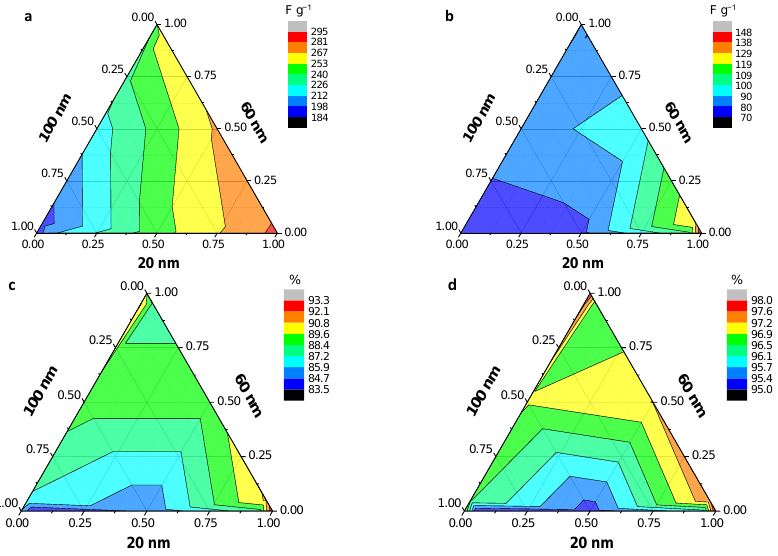
Figure 12. Effect of binary nanoparticle packing on electrode performance. Ternary diagrams for nanospheres of three different diameters showing the distribution of ( a , b ) specific capacitance and ( c , d ) coulombic efficiency as a function of the mixed weight fraction ( f m ) measured at ( a , c ) 0.1 A·g −1 and ( b , d ) 1.0 A·g −1 . A three-electrode system was used with 1 M sulfuric acid solution. The E c values were calculated from the charge/discharge curves. Reprinted with permission from [123]. Copyright